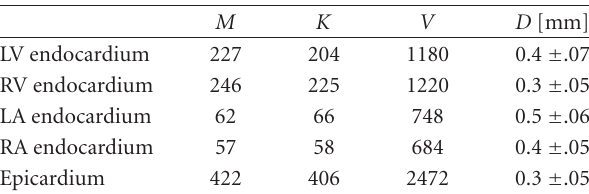
Epicardium 422 406 2472 0.3 ±